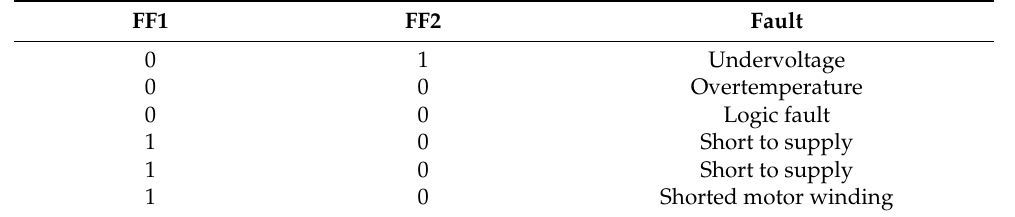
Table 6. Health status bits (FF1 and